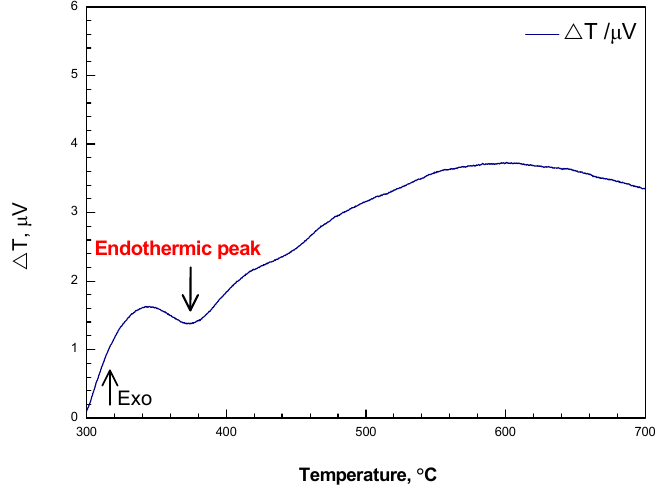
Figure 4. The di ff erential thermal analysis curve of Re, ReO 2 , and ReO 3 Figure 4. The differential thermal analysis curve of Re, ReO 2 , and ReO 3 .